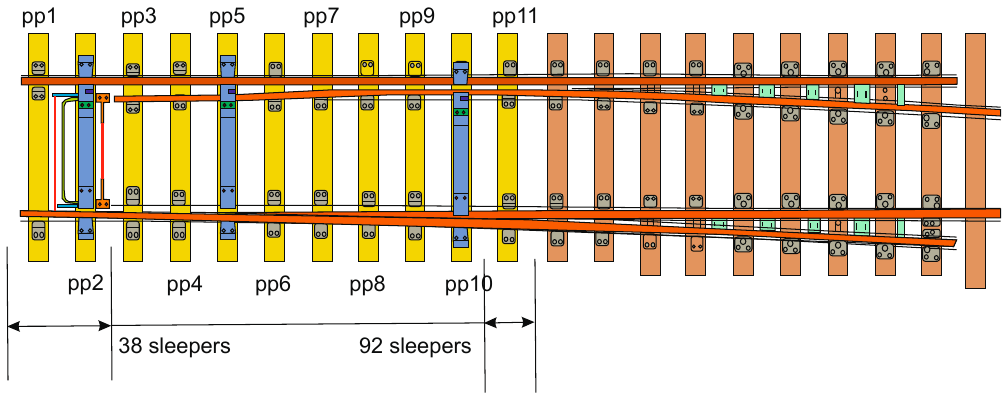
Figure 2. Position of measuring points. The points were positioned in such a way as to eliminate the influence of deflection at neighboring measurement points. The measurement train passing at 5 km/h caused